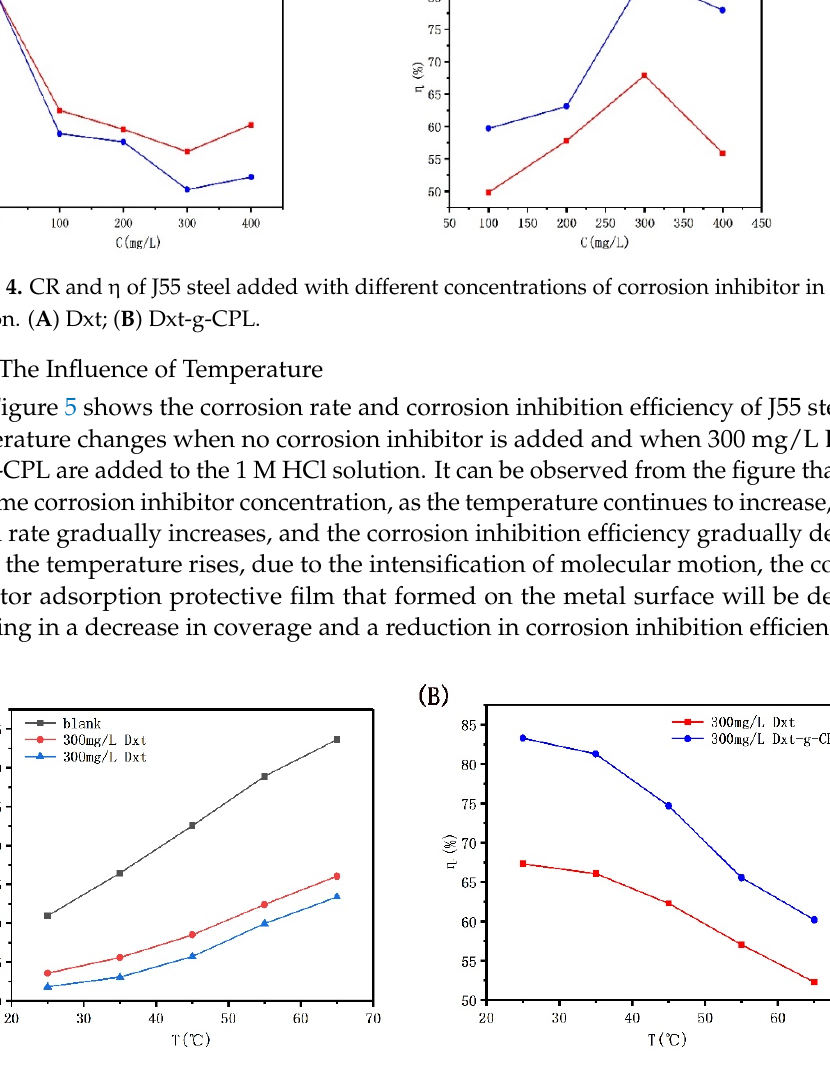
Figure 5. CR and η of J55 steel in 1 M HCl solution with different corrosion inhibitors as a function of temperature. ( A ) T-CR; ( B ) T- η .